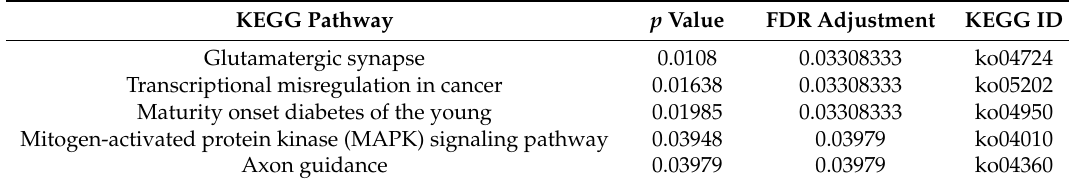
Table 2. Target genes of miR-375 by KEGG pathway analysis.